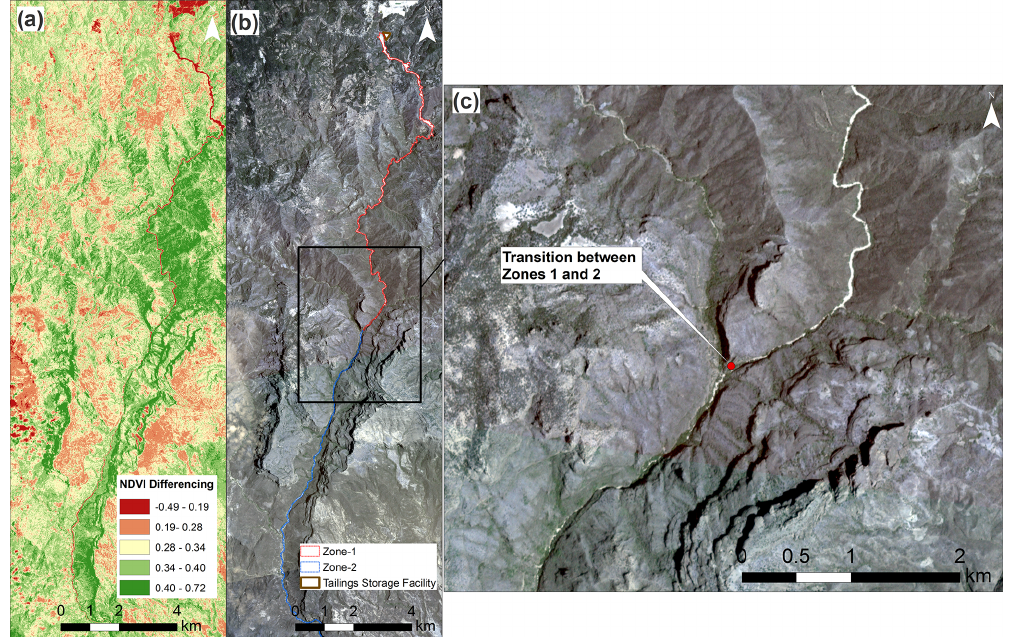
Figure 5. Aerial views of the tailings dam breach at the Cieneguita mine in Mexico, 4 June 2018. The NDVI differencing change detection technique was used to help delineate Zones 1 and 2 inundation areas (a) . Zones 1 and 2 are shown in the red and blue dashed polygons, respectively (b) . The inset image (c) shows the transition between Zones 1 and 2 (red dot). Image courtesy of Planet Labs, Inc. (12 June